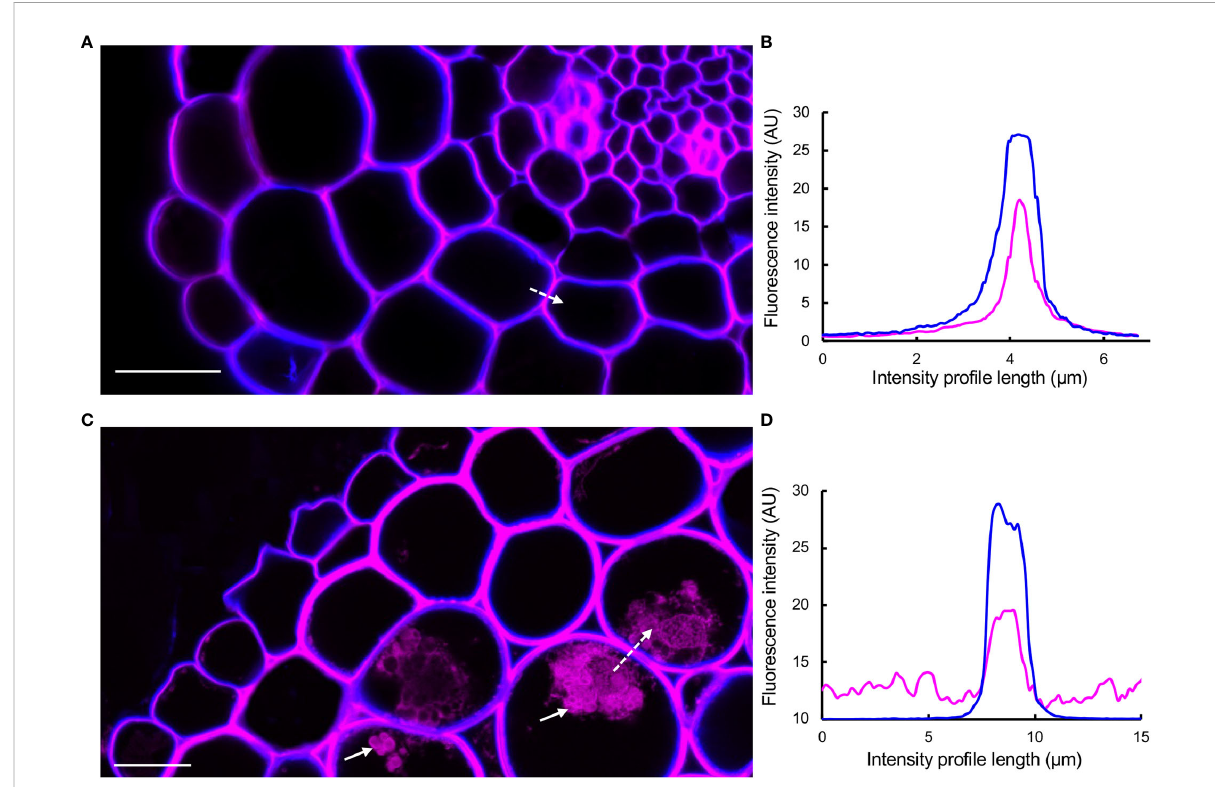
FIGURE 7 DMACA (magenta)/Calco fl uor White (blue) double staining detected by Airyscan microscopy revealing the location of PAs in cell walls and intracellular areas in lateral root cross-sections (taken 500 µm from root tip) of Populus tremula x Populus tremuloides . (A) Young root at 7 days after emergence (dae). (B) Graph representing intensity pro fi les of DMACA (magenta-colored lines) and Calco fl uor White (blue-colored lines) measured along the dashed white arrow in (A) . (C) Old lateral root at 28 dae. (D) Graph representing intensity pro fi les of DMACA and Calco fl uor White measured along the dashed white arrow in (C) . The solid white arrows in (C) show the presence of PAs intracellularly. Scale bars = 20 µm. The experiment was performed on 3-4 roots originating from separate plants per time point yielding similar results as shown